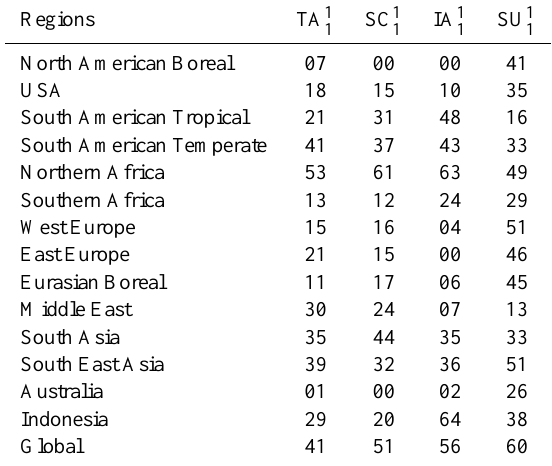
Table 2. Uncertainty reduction (%) on methane emissions for the default configurations.